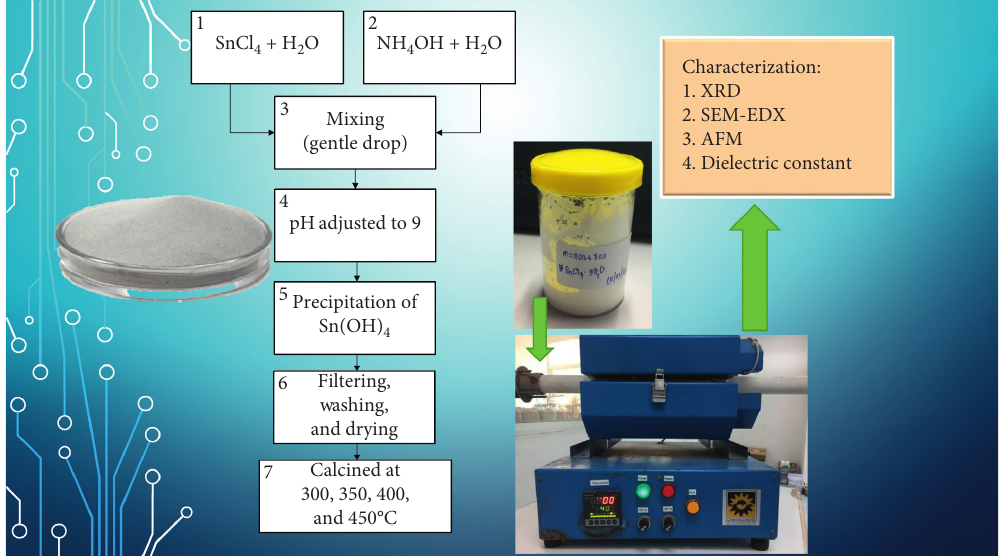
Figure 1: The precipitation process of investigated SnO